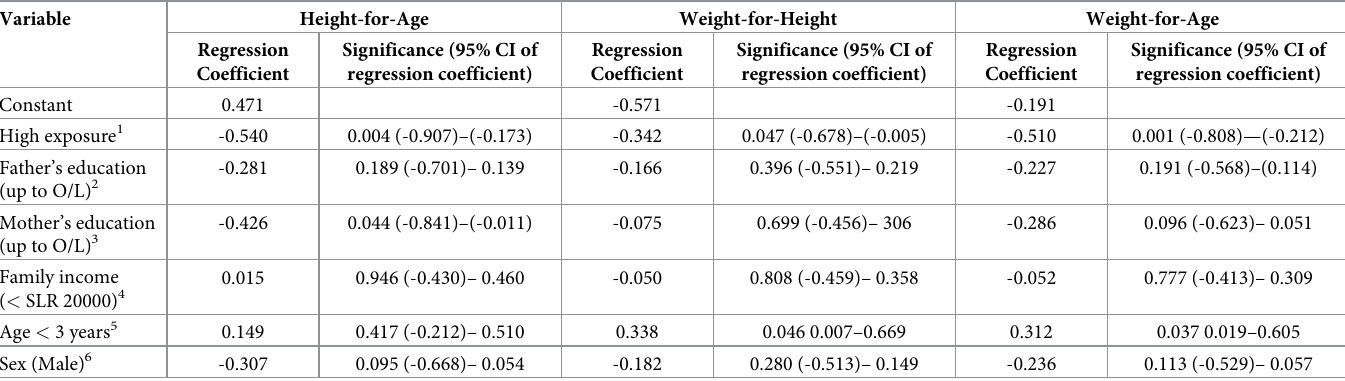
Table 4. Summary of multiple regression analyses using growth parameters as the dependent variable.